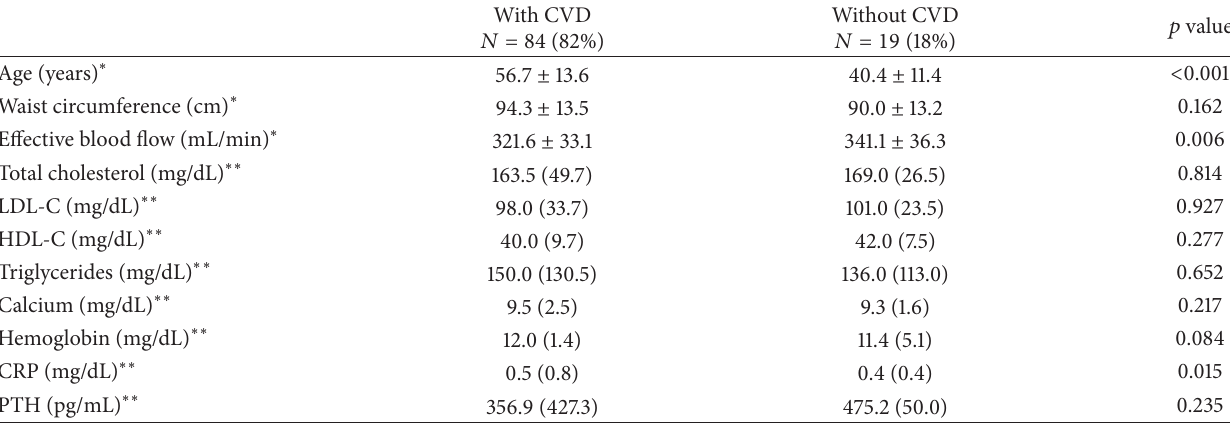
Table 1: Clinical and biochemical data in the population at CNSR categorized by cardiovascular disease.